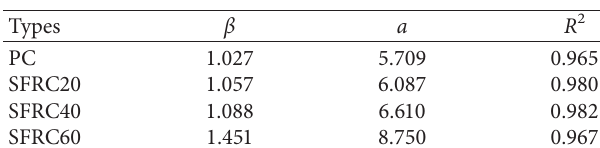
Table 5: Fitting results of the frost damage in Weibull